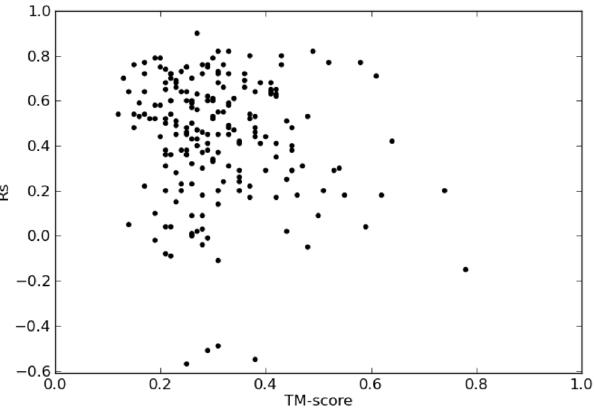
Figure 3. Impact of structure prediction quality (TM-score) on backbone dynamics predictions (R S